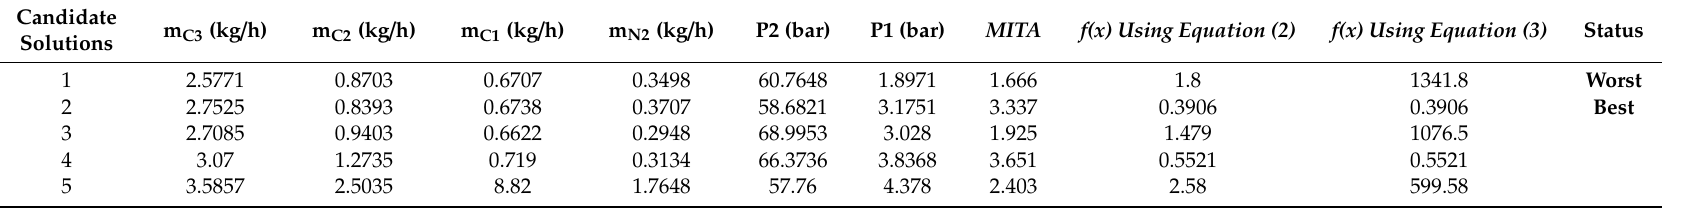
Table 10. Updated candidate solutions of the SMR process after comparing Tables 6 and 7 (second iteration